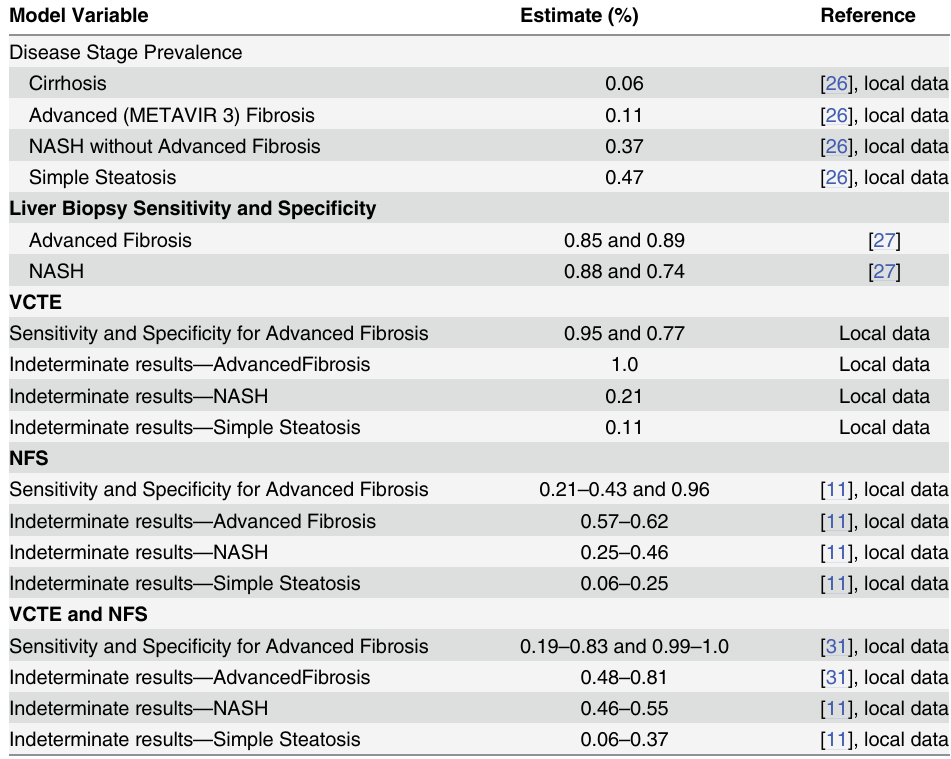
Table 1. Estimates of Test Performance and Disease Prevalence for the